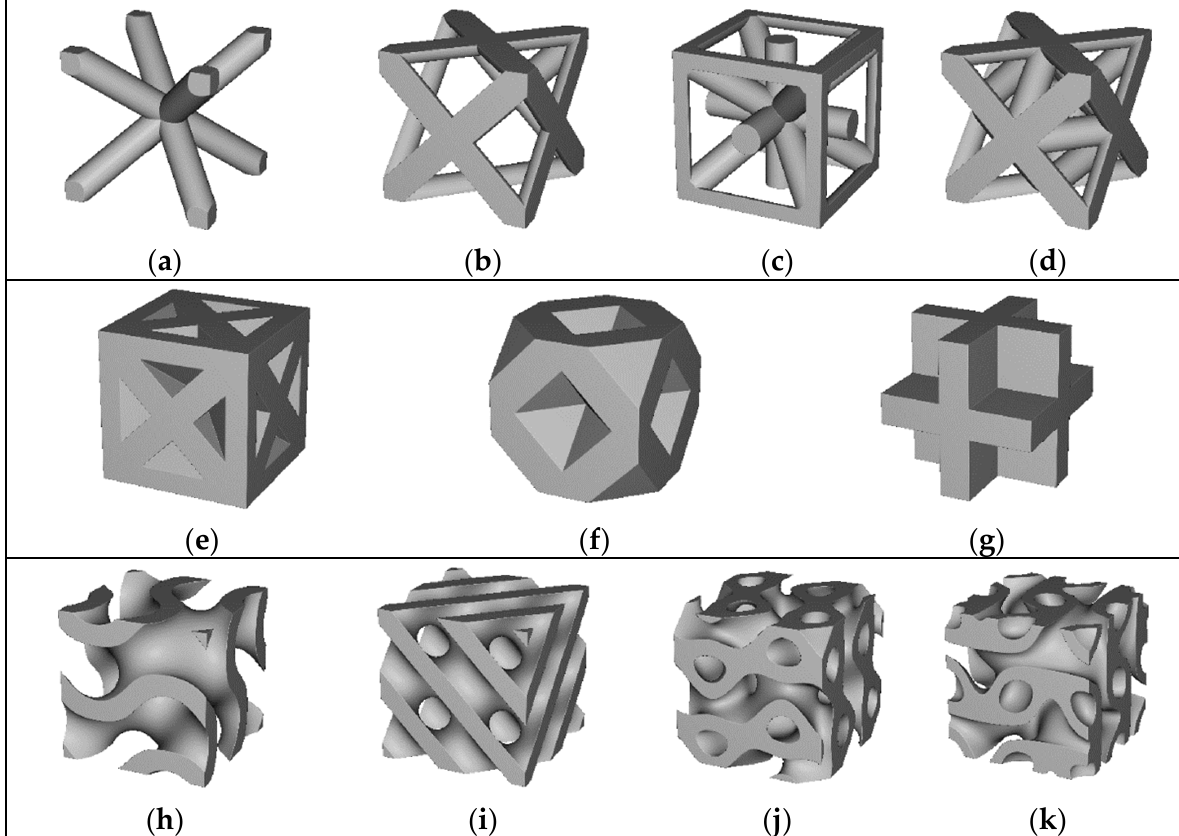
Figure 1. Open cell beam-based lattice structures ( a – d ), closed-cell foam based structures ( e – g ), and triply periodic minimal surface (TPMS) structures ( h – k ); (a) body centered cubic unit cell; ( b ) face centered cubic unit cell; ( c ) isotruss unit cell; ( d ) octet truss unit cell; ( e ) body centered cubic foam; ( f ) face centered cubic foam; ( g ) simple cubic foam; ( h ) gyroid TPMS unit cell; ( i ) diamond TPMS unit cell; ( j ) SplitP TPMS unit cell; ( k ) Lidinoid TPMS unit cell.